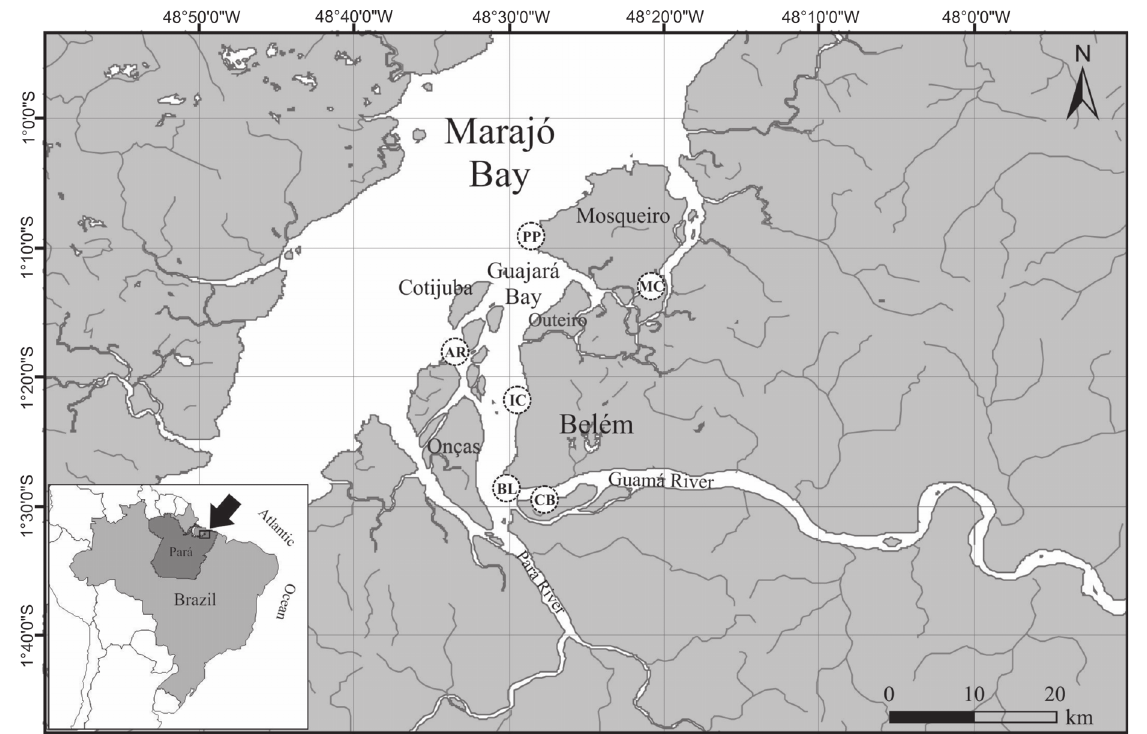
Figure 1. The study area, showing the sampling sites: (PP) Porto do Pelé, Mosqueiro Island; (MC) Marinhas Channel, Mosqueiro Island; (AR) Arapiranga Island; (IC) Icoaraci; (BL) Belém; (CB) Combu